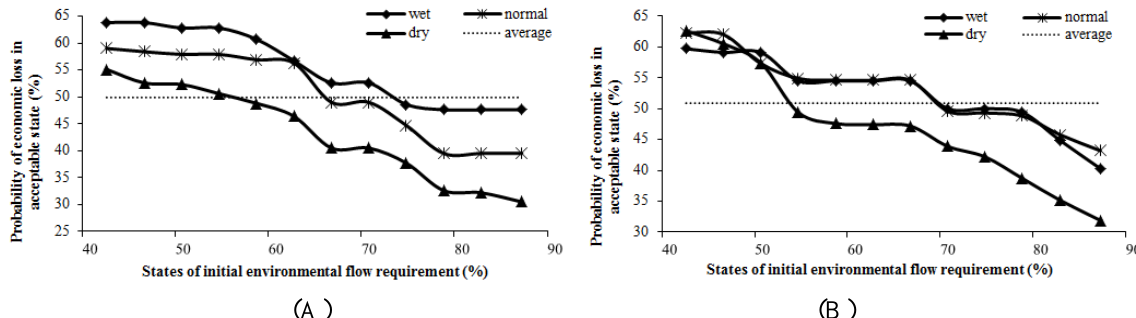
Figure 7 Fig. 7. Comparison of the outcomes in the wet, normal, and dry years, (A) for winter wheat irrigation stakeholders, and (B) for summer corn irrigation